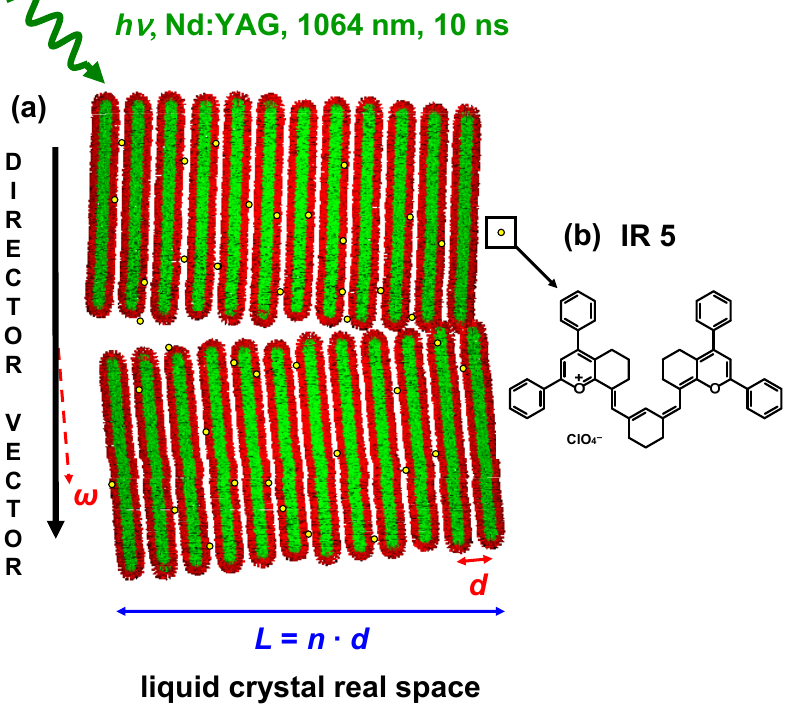
Figure 1. (a) Schematic presentation of the liquid crystal microscopic structure for two crystallites in real space. The lamellae are represented as rods with hydrophobic carbon chains (green) and polar heads (red). The periodic arrangement of the system is defined in terms of d = inter-lamellae spacing, L = crystallite thickness and ω = angle between director vector and normal vector. (b) Infrared sensitive laser dye IR